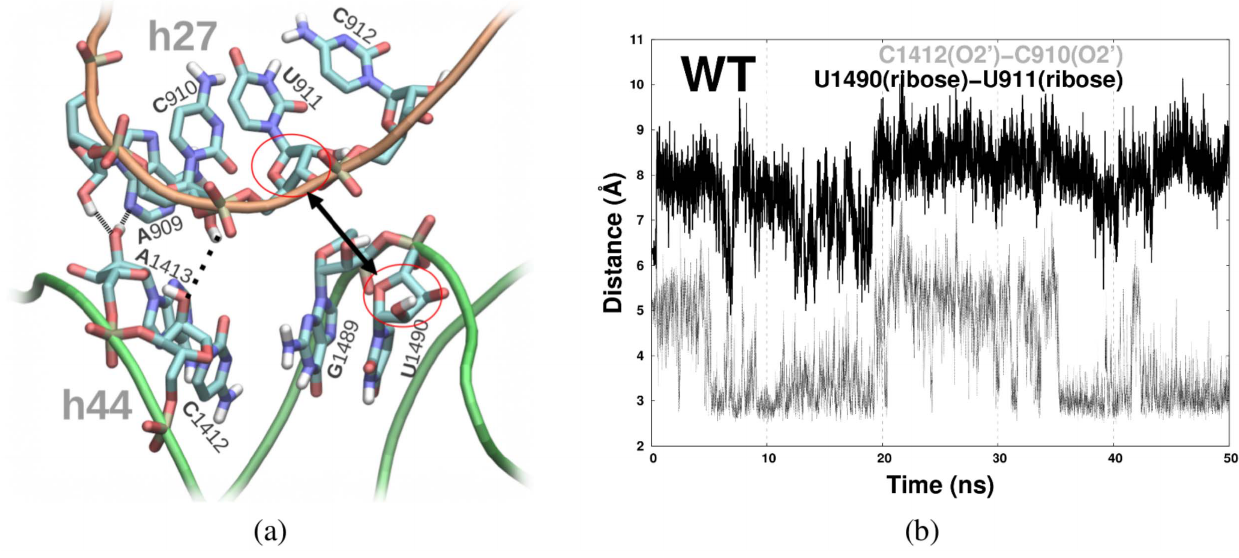
Figure 9. Relative position of h44 and h27. a) The two stable H-bonds (fine dashed line) and one unstable H-bond (dotted line) between h44 and h27 are shown, along with the neighboring regions of h44 and h27 (black arrow). b) The time-evolution of specific h27 ??? h44 distances (shown in (a)) are plotted for the wild-type trajectory.